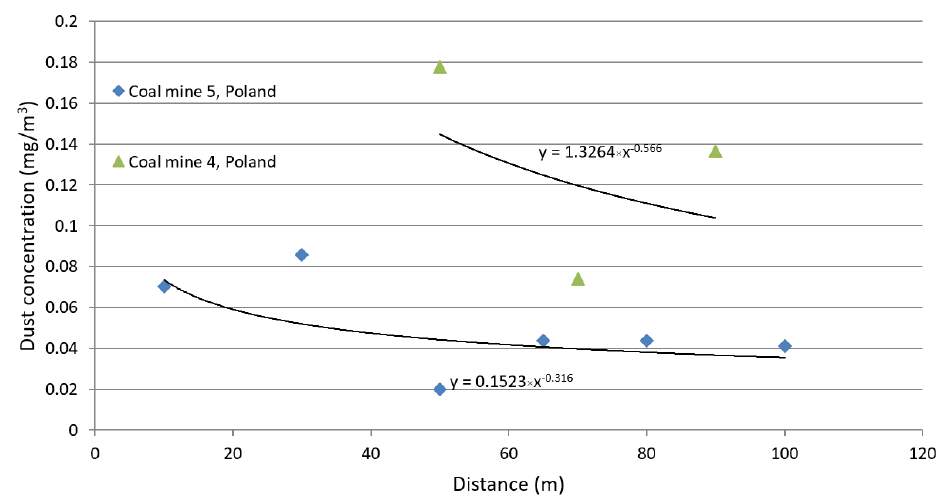
Figure 10. Characteristics of the average distribution of PM2.5 dust concentration in the gates depending on the distance, based on the results from the IPSQ analyzer with the functions describing them.